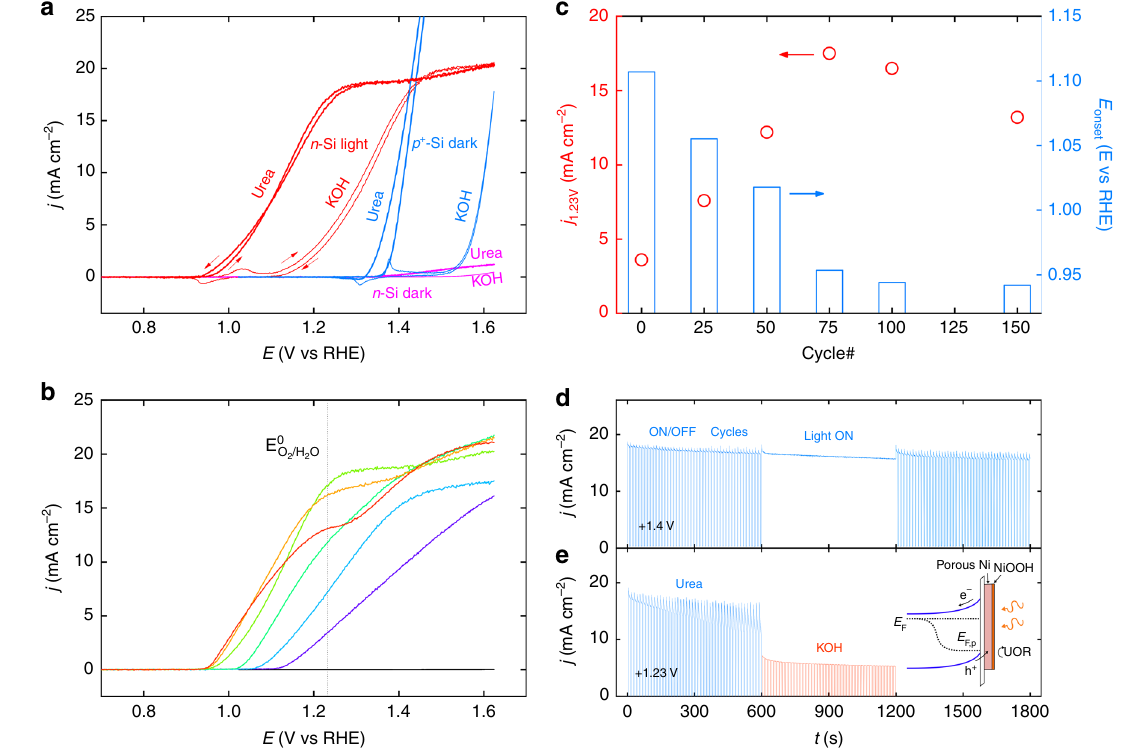
Fig. 6 Photoelectrocatalysis on n -Si/SiO x /Ni/Ni(OH) 2 . a CVs of (light blue) p + -Si/SiO x /Ni/Ni(OH) 2 - 75cy in the dark, (pink) n -Si/SiO x /Ni/Ni(OH) 2 - 75cy in the dark and (red) n -Si/SiO x /Ni/Ni(OH) 2 - 75cy under simulated sunlight; the CVs recorded in 1 M KOH are represented by thin lines and the CVs recorded in 0.33 M urea + 1 M KOH are represented by thick lines. b LSVs of (black) n -Si/SiO x and n -Si/SiO x /Ni/Ni(OH) 2 , prepared with different number of cycles ((purple) 0cy , (light blue) 25cy , (cyan) 50cy , (light green) 75cy , (yellow) 100cy , and (red) 150cy ) under simulated sunlight in 0.33 M urea + 1 M KOH. All voltammograms were recorded at 10 mV s − 1 . c Values of (red disks) j 1.23V and (blue bars) E onset recorded under simulated sunlight in 0.33 M urea + 1 M KOH. d , e j vs t plots for UOR on n -Si/SiO 75cy recorded at 1.40 V ( d ) and 1.23 V ( e ) under intermittent and continuous light x /Ni/Ni(OH) 2 - illumination in 0.33 M urea + 1 M KOH. In e , the electrolyte was replaced at 600 s by 1 M KOH. Inset: schematic band diagrams of a n -Si/SiO x